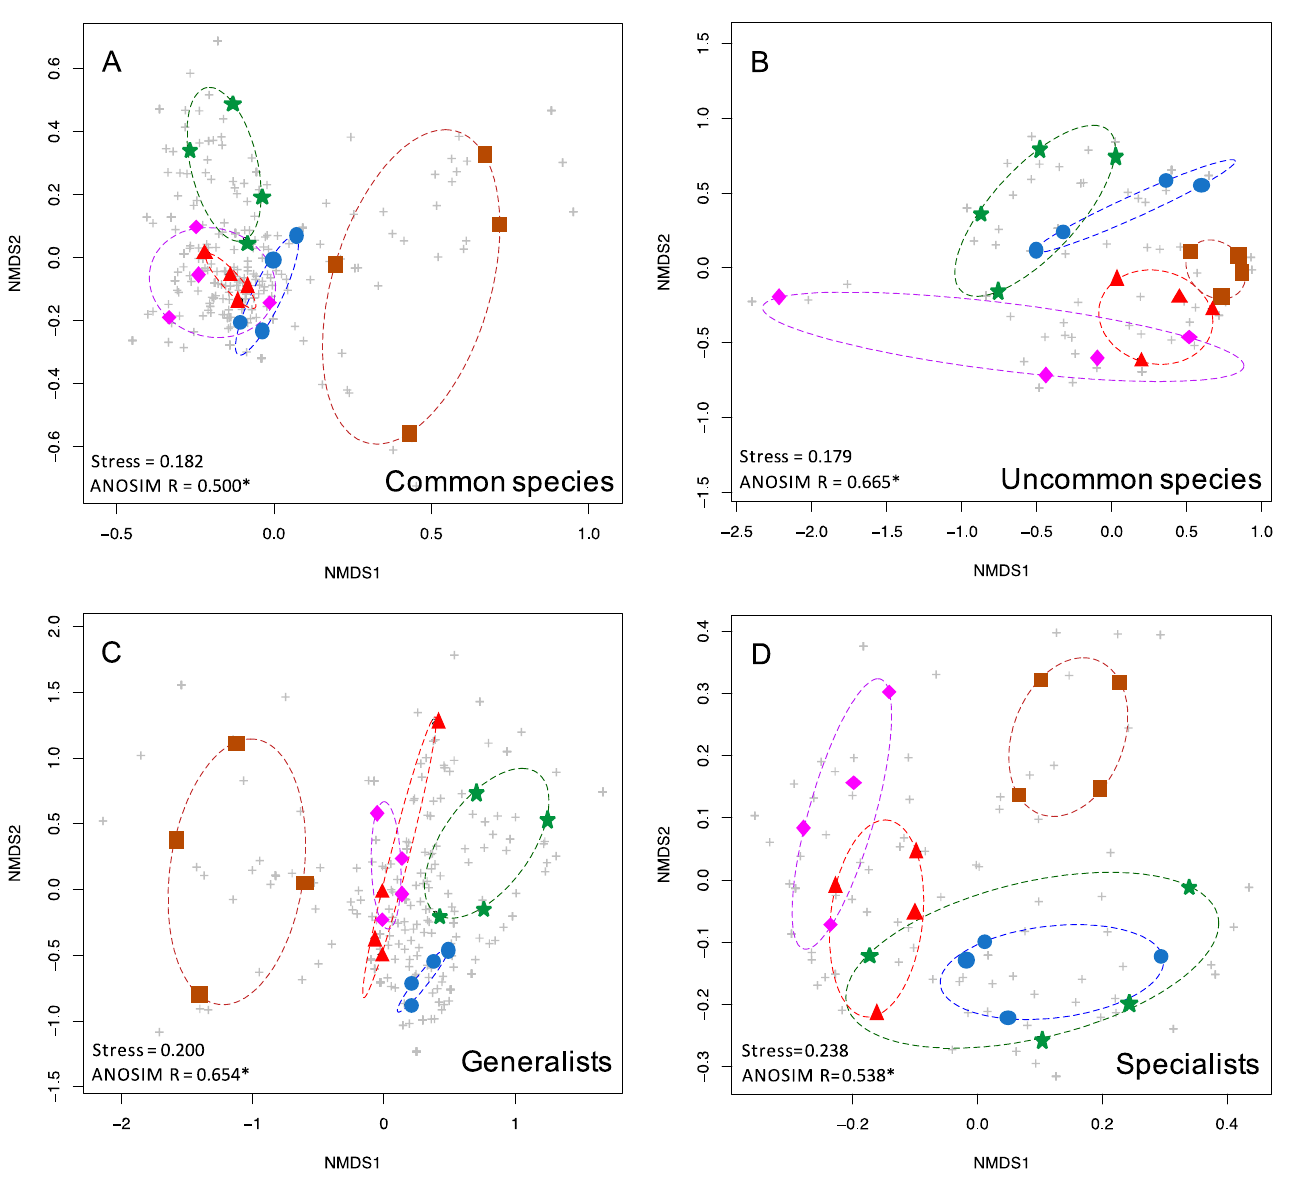
Figure 3. nMDS plots showing the two-dimensional ordination for moth communities in five habitat types. Colored symbols are as in Figure 1. Grey pluses indicate individual species. Shown here are ( A ) common species (363 spp.), ( B ) uncommon and rare species (147 spp.), ( C ) generalists (325 spp.), and ( D ) specialists (123 spp).